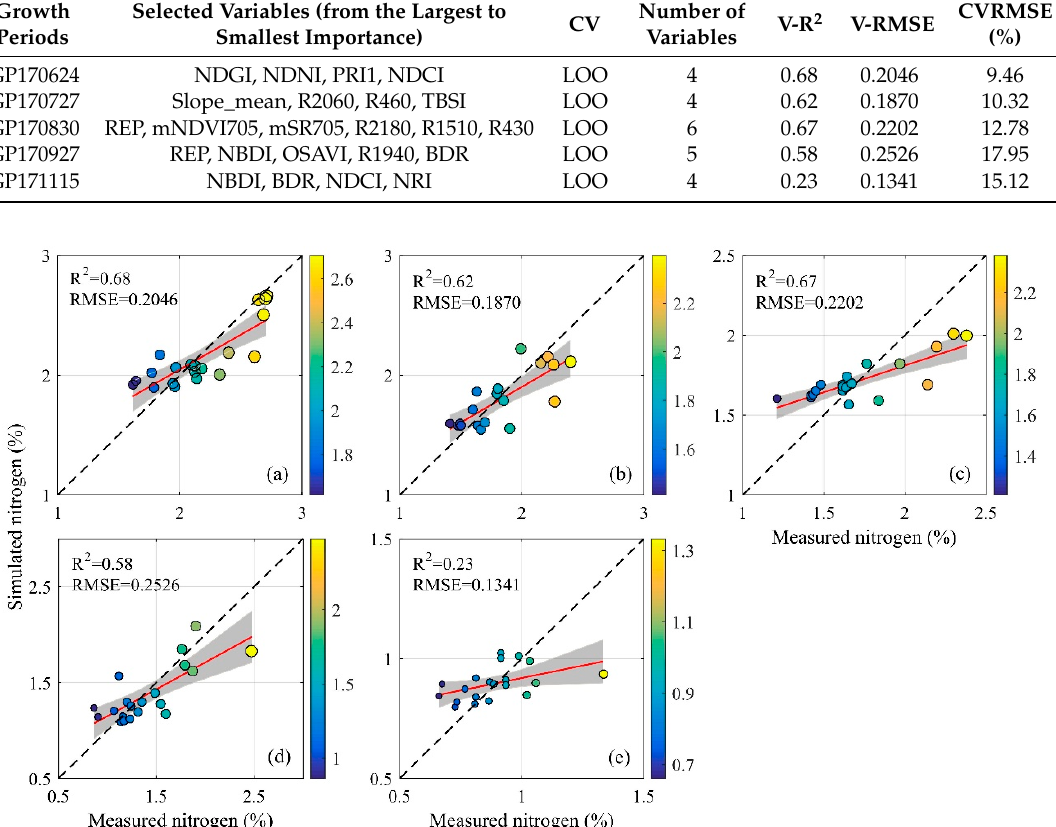
Table 3. RF model of the forage N contents during different growth periods. V-RMSE: the RMSE of the validation dataset; V-R 2 : the R 2 of the validation dataset; CVRMSE: the coefficient of variation of the RMSE.